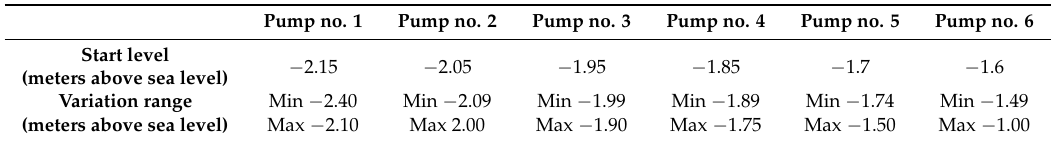
Table 5. Variation range for activation levels.